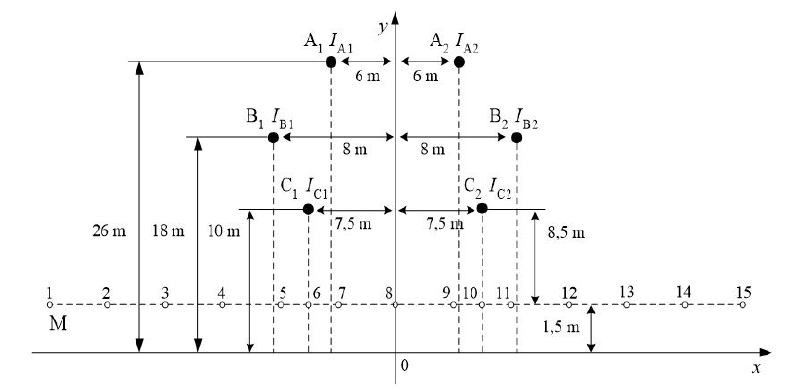
Figure 3. Positions of the measurement point